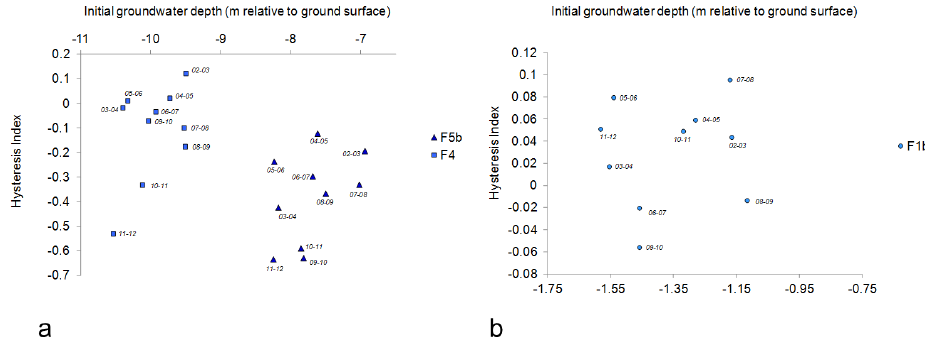
Figure 8. Year-to-year variations, for the 10 monitoring years, of the hysteresis indexes: (a) HSS-F5b(Q) and HSS-F4(Q) (HI) versus the initial groundwater table level depth in the corresponding hillslope piezometer (F5b or F4) and (b) HSS-F1b(Q) versus the initial groundwater table level depth in the piezometer in the riparian area